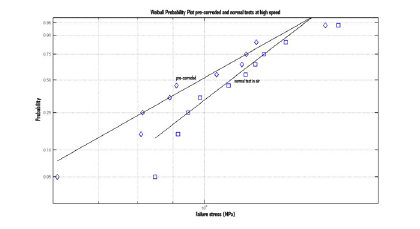
Figure 10: Weibull plot of results of fast tests in air on normal and pre-corroded specimens.